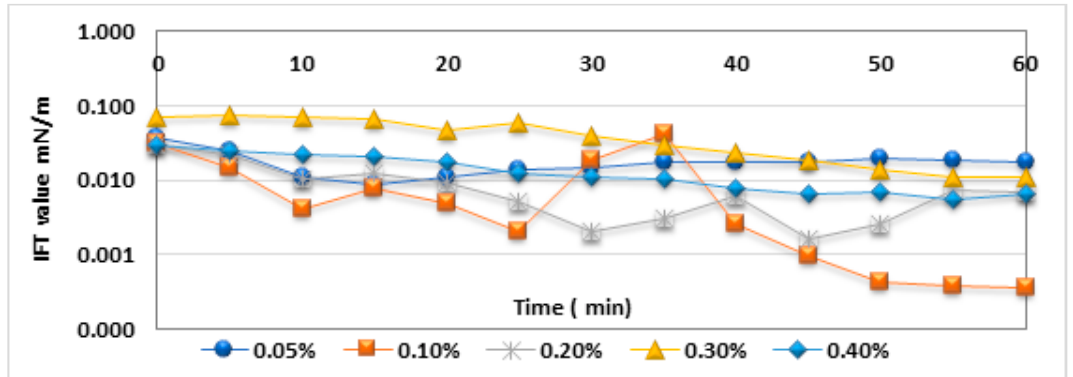
Figure 9. Dynamic Interfacial Tension (IFT) of surfactant in seawater at different concentrations.